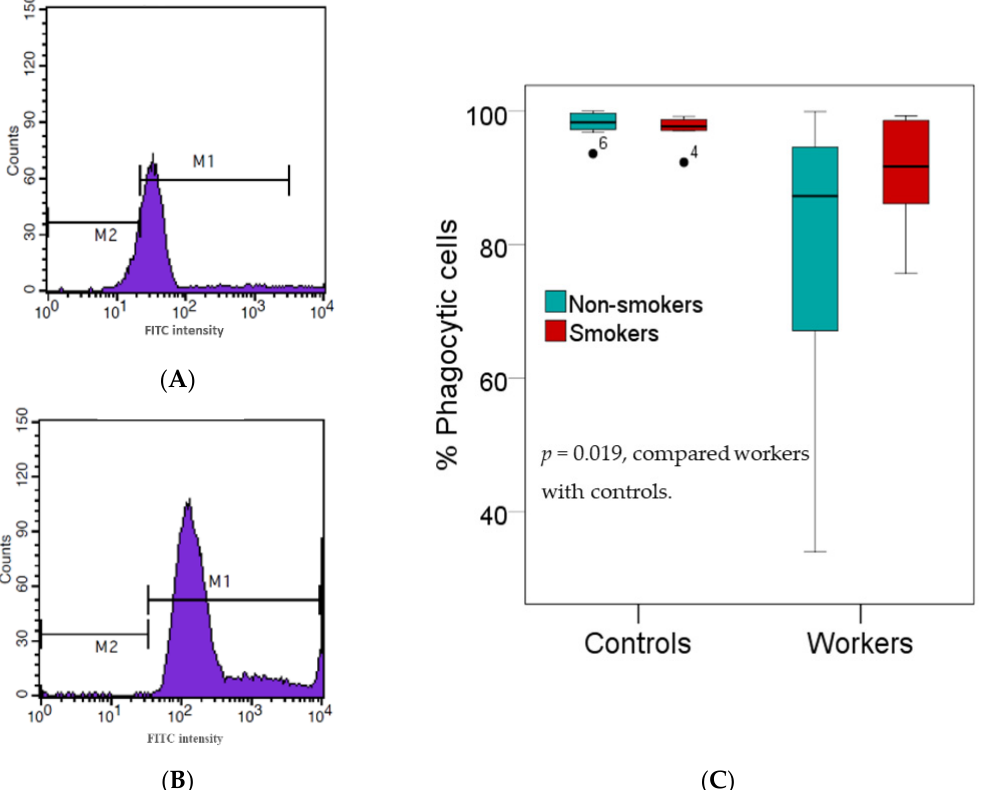
Figure 1. Effects of high Pb exposure on innate immunity. Histograms show the percentages of phagocytic cells in one Pb-exposed worker ( A ) and one control subject ( B ). Boxplots compare percentages of phagocytic cells in controls versus workers, non-smokers, and smokers included ( C ). Outliers were the data points below or above 1.5× interquartile range. The p -value was derived from the Mann–Whitney U test, in which outliers were included.